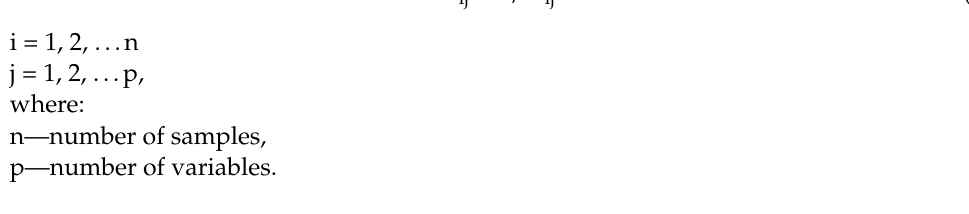
Table 3. Diagnostic variables used in building the environmental